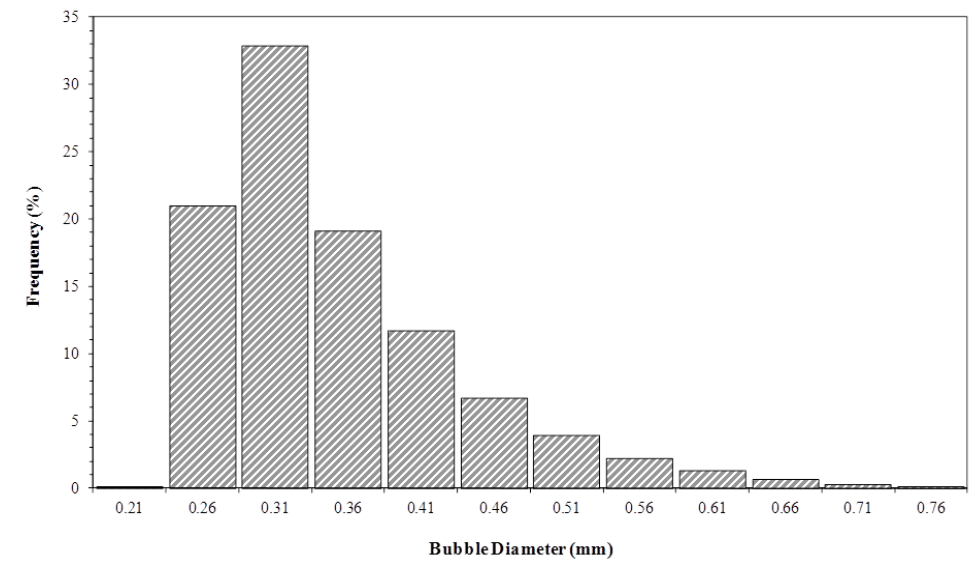
Figure 10. Bubble size distribution in the liquid column. Initial biosurfactant concentration of 0.7 kg m − 3 and gas flow rate of 1.0 × 10 − 6 m 3 s − 1 .